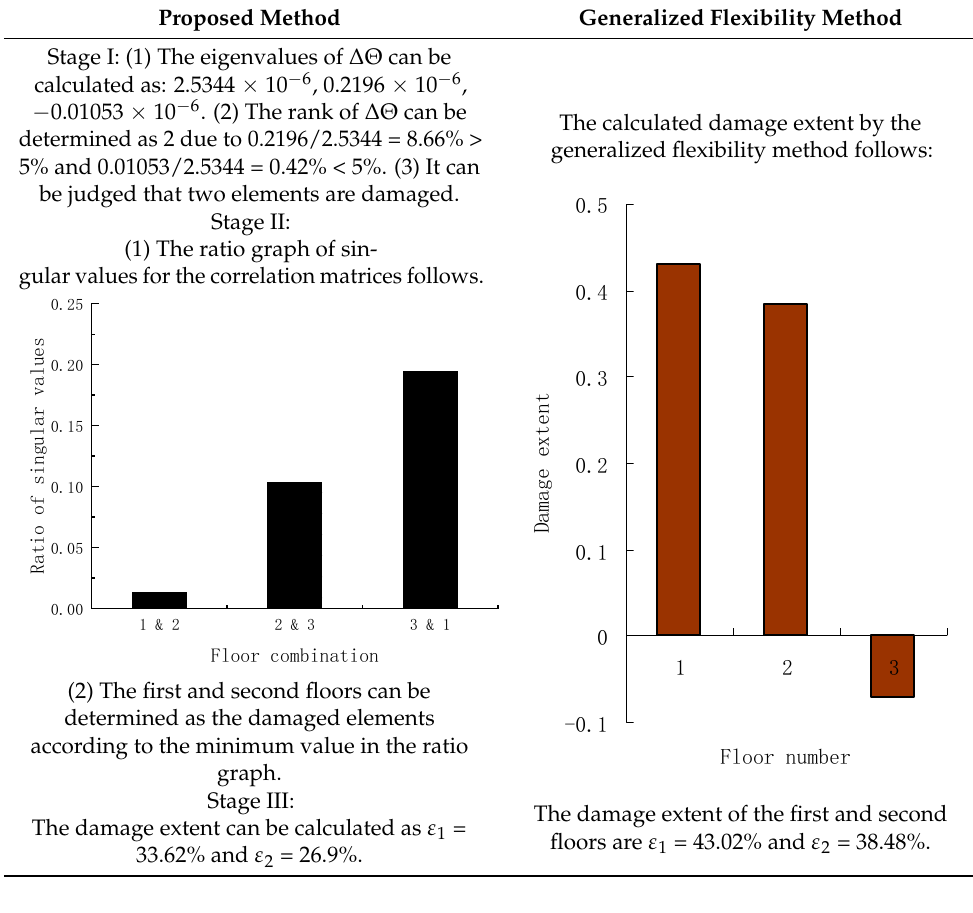
Table 10. The damage assessment results by the proposed method and the generalized flexibility method for damage case 2 of the experimental structure.